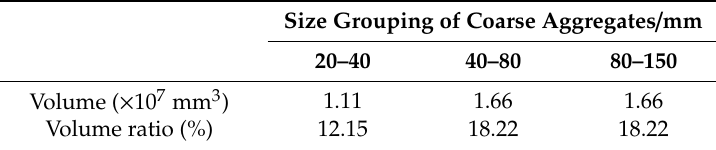
Table 1. Aggregate components of fully graded concrete